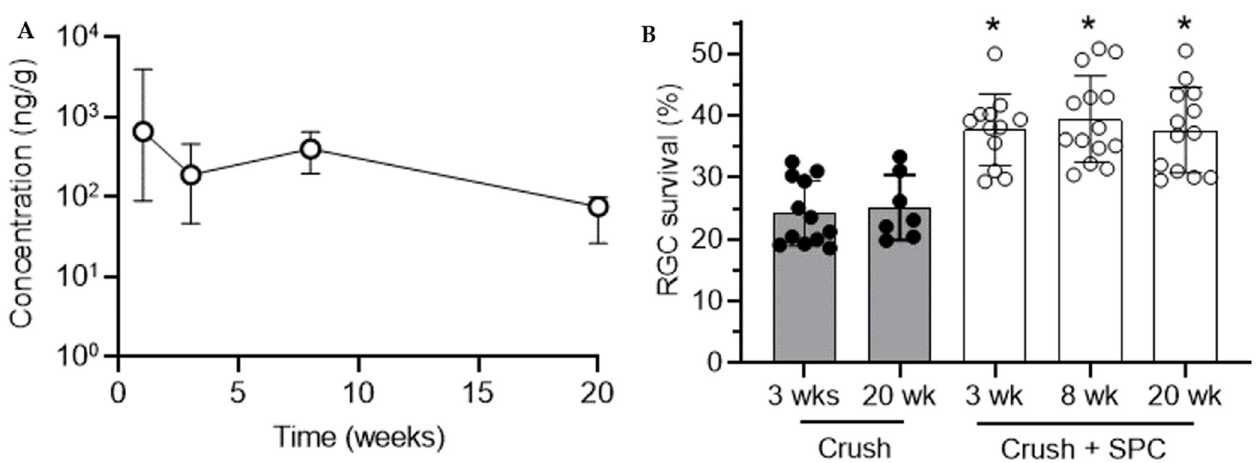
Figure 2. Pharmacokinetics and efficacy in protecting retinal ganglion cells (RGCs) in a rat model. ( A ) A single unilateral subconjunctival injection of SPC microcrystals (200 µ g in 5 µ L) was given in rats, and tissues were analyzed for combined sunitinib and N -desethyl sunitinib levels in the retina at the specified time points ( n = 4–9). Units shown as ng combined drug per g of tissue (ng/g). Data shown as median ± IQR. ( B ) SPC microcrystals (200 µ g in 5 µ L) were injected unilaterally and an optic nerve crush procedure was performed 2 weeks prior to the indicated time points ( n = 7–12). After 2 weeks, the percentage of surviving RGCs was calculated compared to the healthy fellow eye. Data shown as mean ± SD. * p < 0.05 compared to control crush animals at 3 and 20 weeks. Statistical analyses conducted by one-way ANOVA with multiple comparisons.